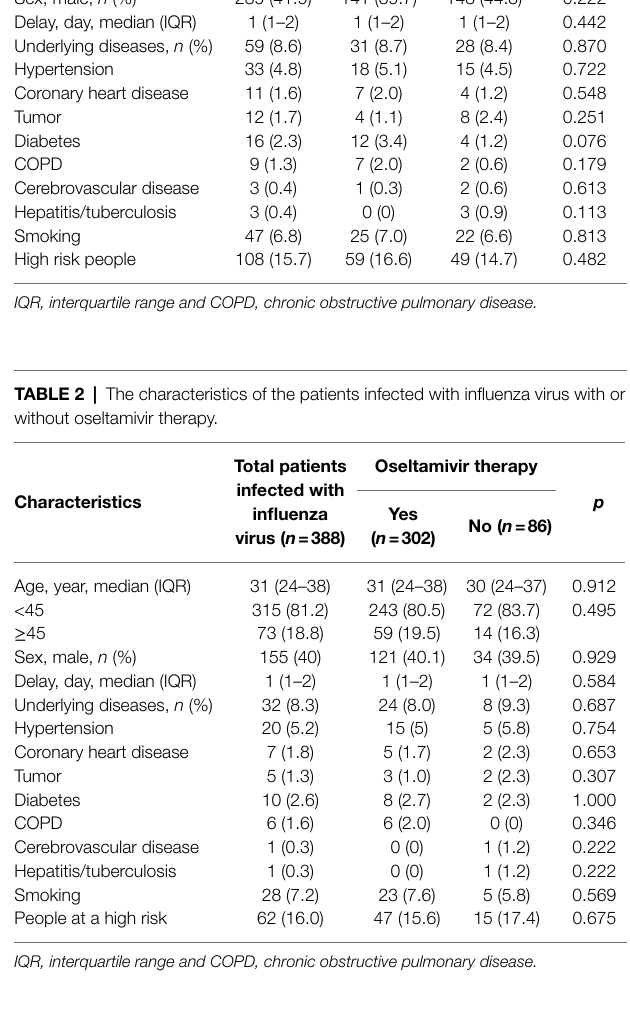
Characteristics